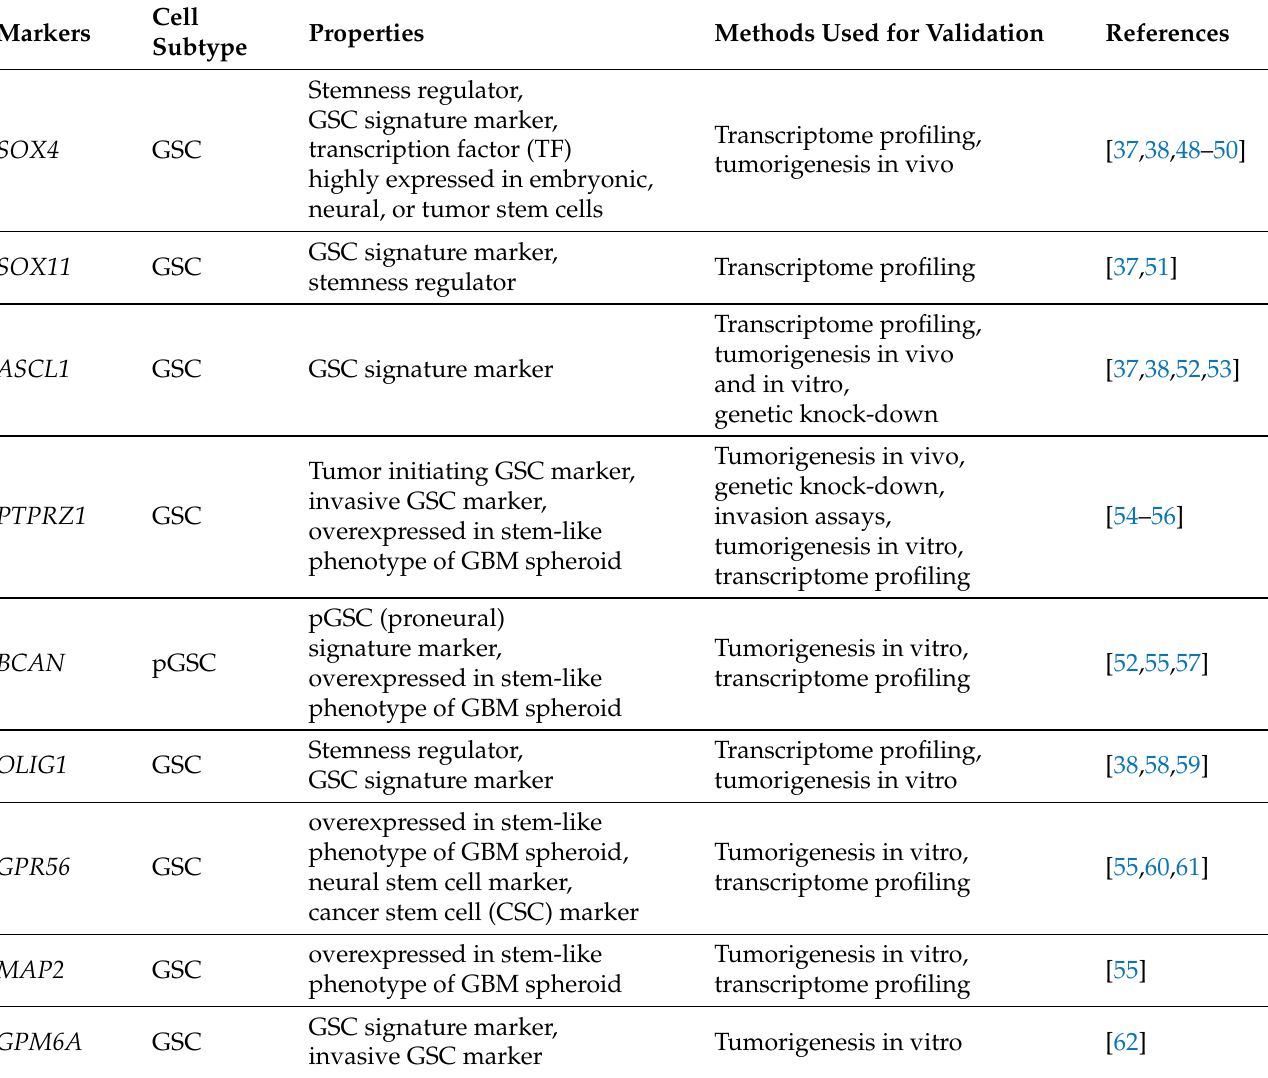
Table 1. Validation of stemness for highlighted